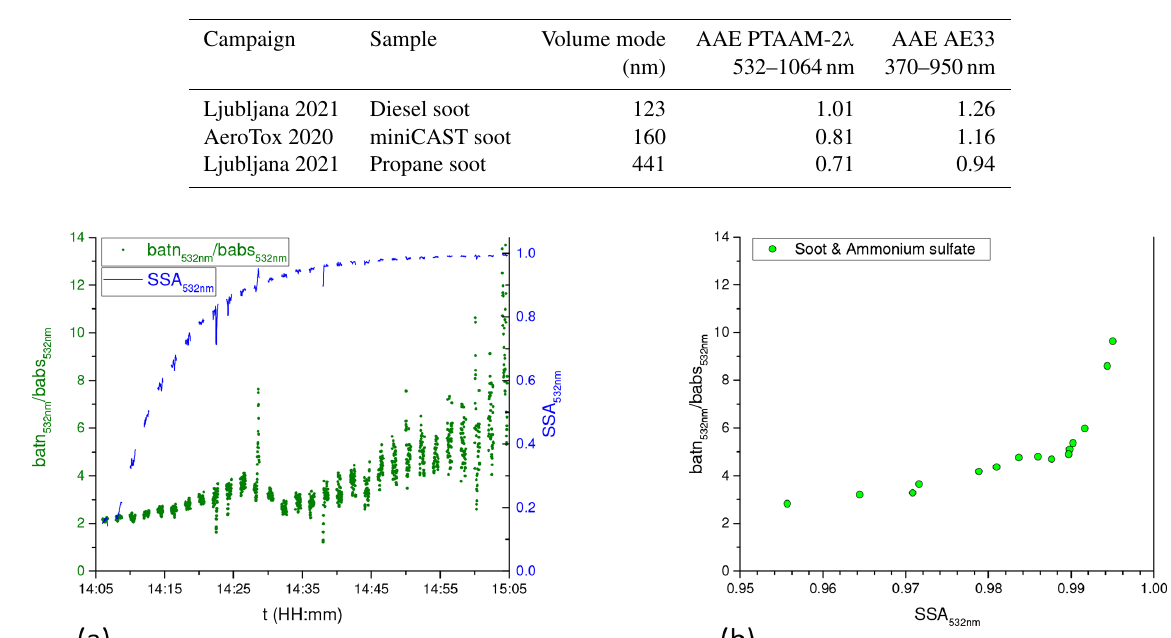
Table 3. The AE33 systematically overestimates the absorption Ångström exponents (AAE) compared to the PTAAM-2 λ .